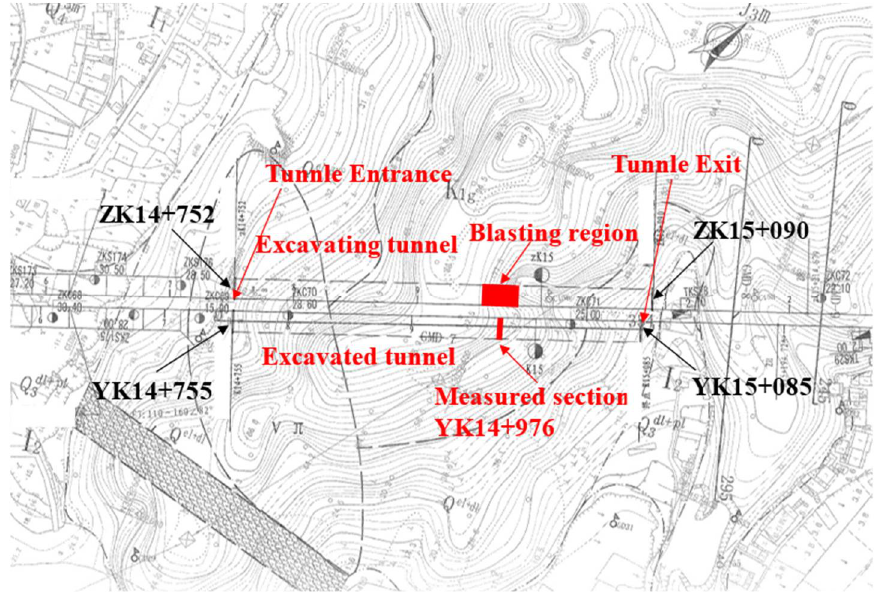
Figure 2. Topographic plan and locations of the twin tunnels.